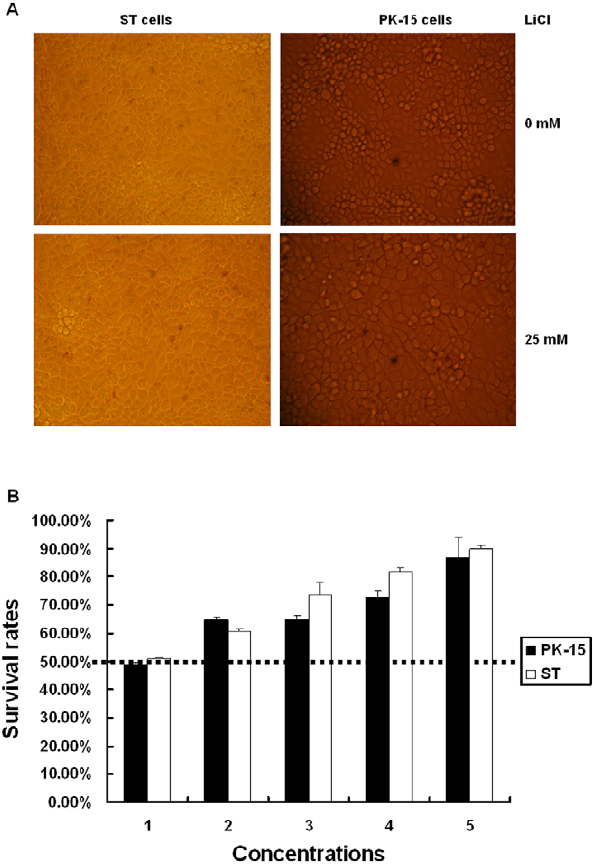
Figure 1. Cell viability analysis by trypan blue staining. The cell viability of two cell lines (ST and PK) was evaluated with trypan blue staining. Mock-treated cells and cells treated with the maximum non- toxic concentration of LiCl were subjected to trypan blue staining and a representative comparison is provided (A). The cell proliferation was analyzed by MTT colorimetric assays. The cell survival rates at different concentrations of drugs are given and 50% above cell survival rate (over broken line) is regarded as non-toxic concentration of LiCl. Concentra- tions 1 to 5 are 100, 50, 25, 20 and 10 mM for PK-15 cells respectively; 50, 30, 25, 20 and 15 mM for ST cells,